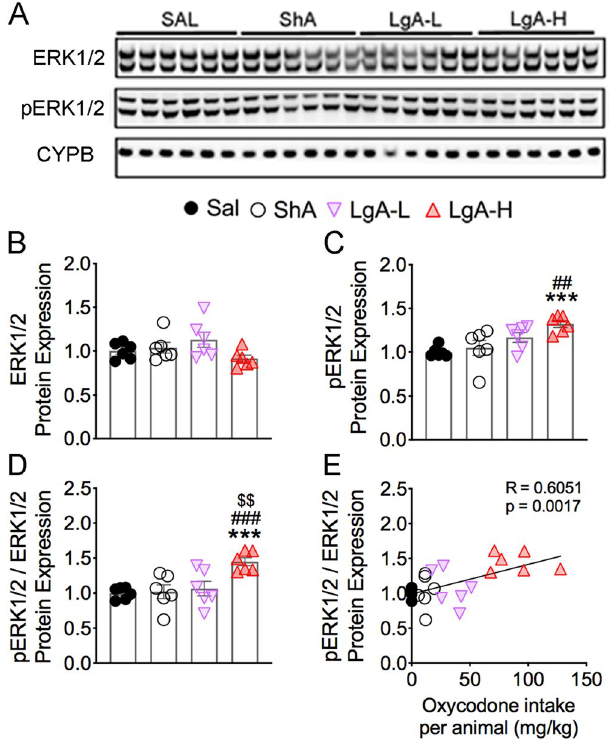
Figure 2. Effects of oxycodone SA on ERK1/2 phosphorylation. ( A ) Images of western blot and ( B, C ) quantification of ERK1/2, and pERK1/2. ( B ) ERK1/2 protein levels were not significantly impacted by oxycodone. ( C ) pERK1/2 abundance was increased in only LgA-H rats. ( D ) pERK1/2/ERK1/2 ratios are substantially increased in the LgA-H rats. ( E ) pERK1/2/ERK1/2 ratios correlate with amount of oxycodone taken. (n = 6 Sal; n = 6 ShA; n = 6 LgA-L; n = 6 LgA-H). Full-length blots are presented in Supplementary Fig. S5. Key to statistics: *** = p < 0.001 in comparison to Sal rats; ##, ### = p < 0.01, 0.001, respectively, in comparison to ShA rats; $$ = p < 0.01, in comparison to LgA-L rats. Statistical analyses are as described in Fig.